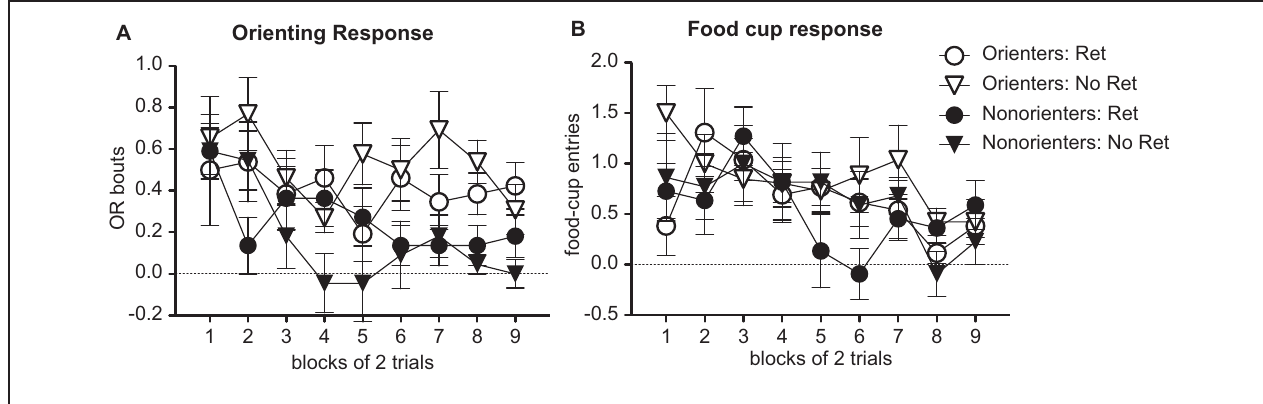
prior to regular extinction trials while No Ret refers to the regular extinction trials without a prior CS presentation. Orienters showed more OR than Nonorienters (A) . There was no difference in food-cup responding among four groups, and all showed comparable extinction rates (B) .